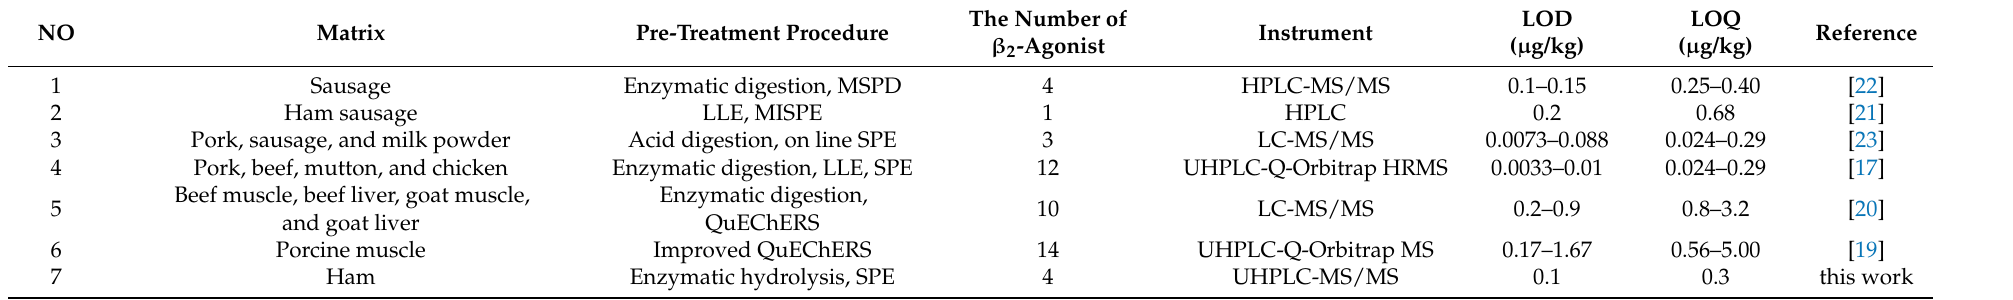
Table 6. Comparison between proposed method and the previous